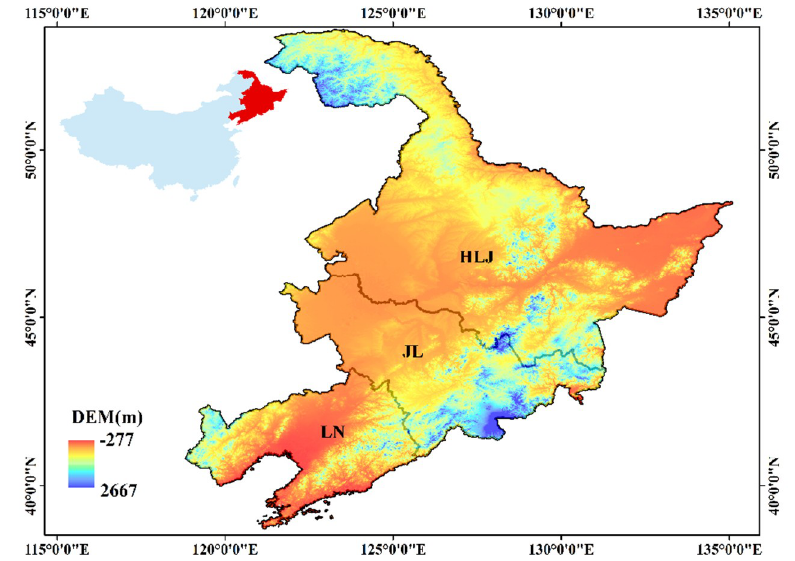
Figure 1. The geographical location of Northeastern China (NEC). The color bar represents the altitude (elevation).